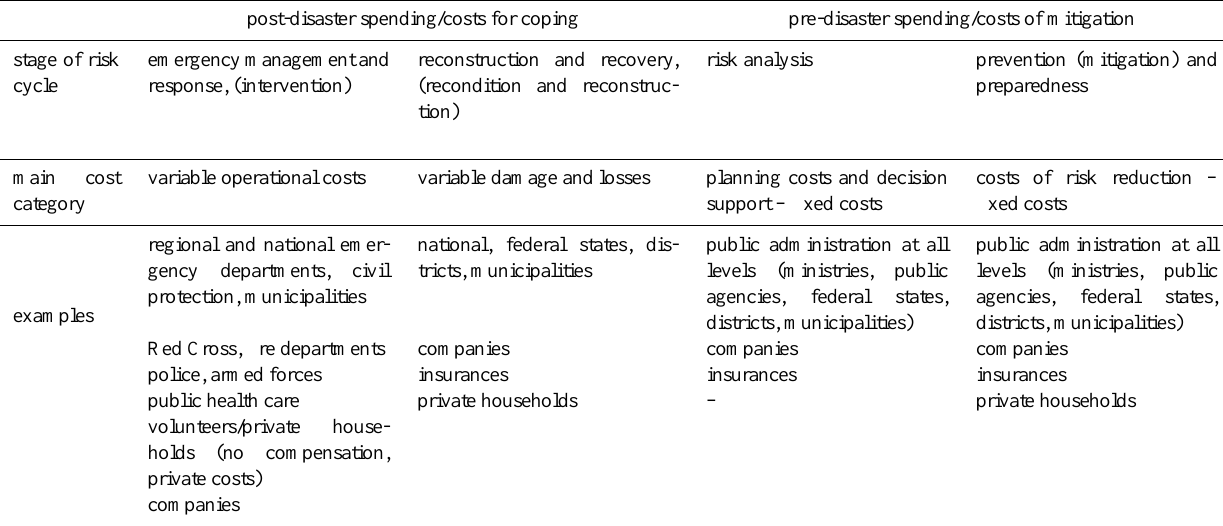
Table 2. Overview of private and public cost benefactors (payers) of natural hazards in Austria; based on concepts of Kienholz et al. (2004) and The World Bank